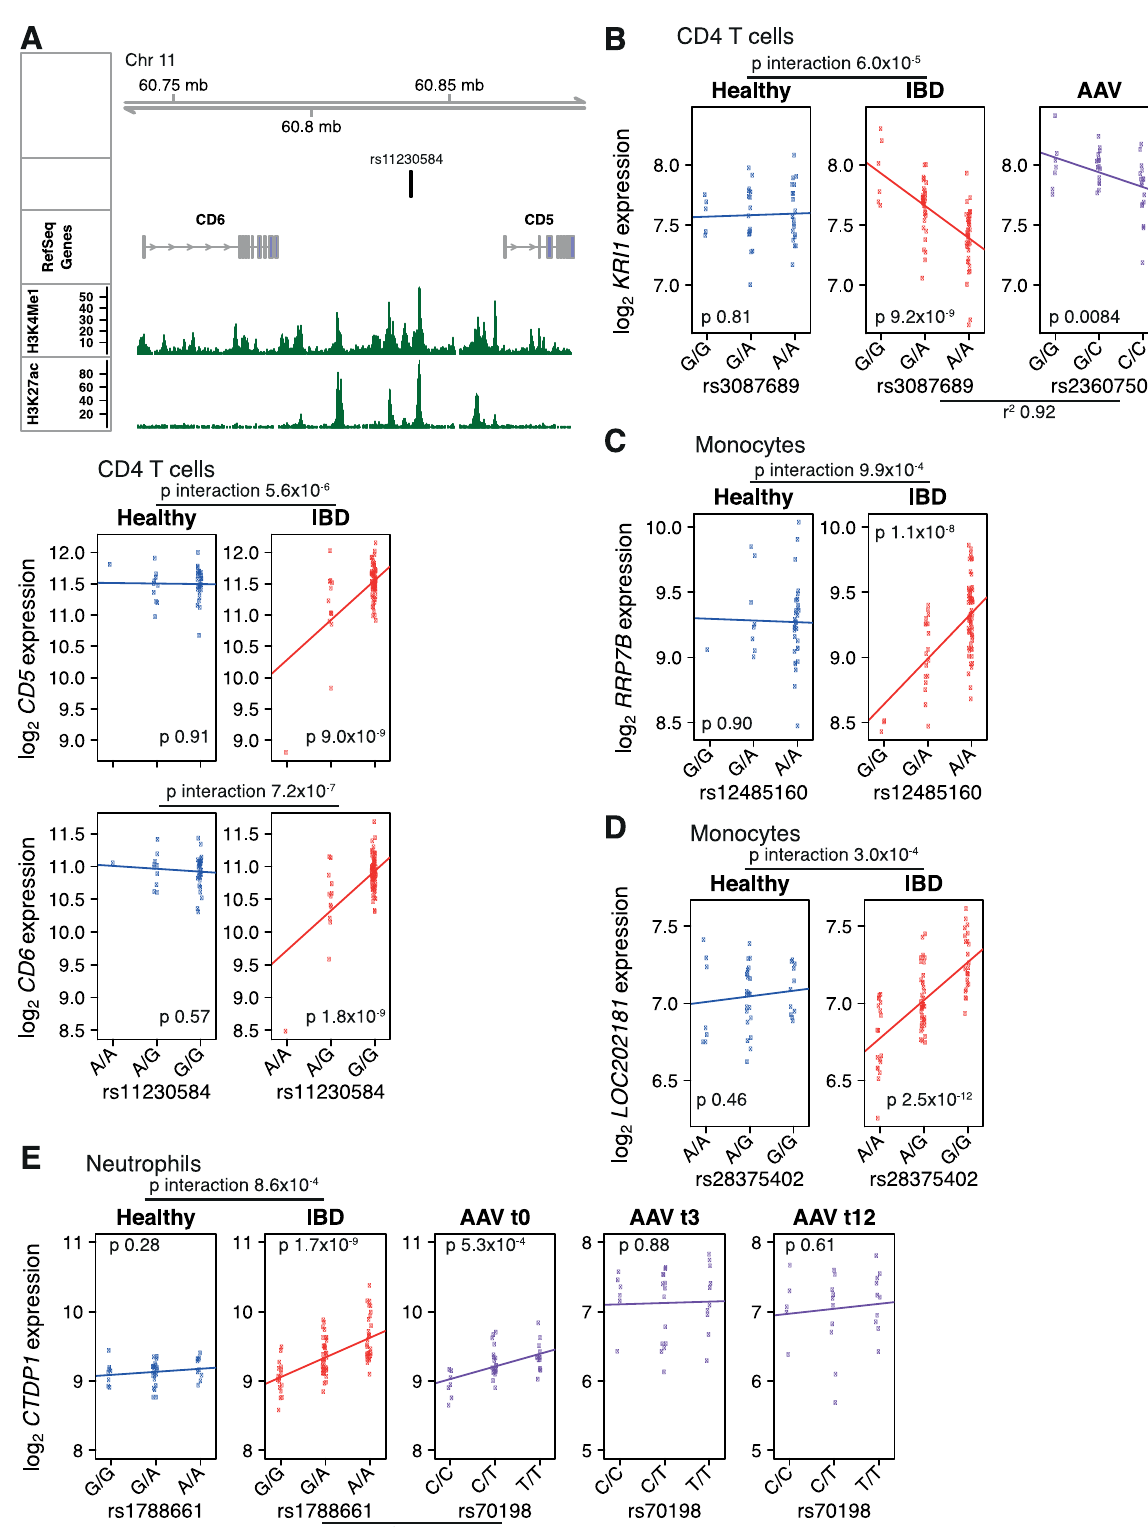
Fig 4. Distinct eQTLs in active inflammatory disease. Analysis using expression data batch-corrected with ComBat. (A) An eQTL for CD5 and CD6 is present in CD4 T cells from patients with active IBD but not in HVs. Upper panel: genomic features around the eQTL SNP including nearby genes